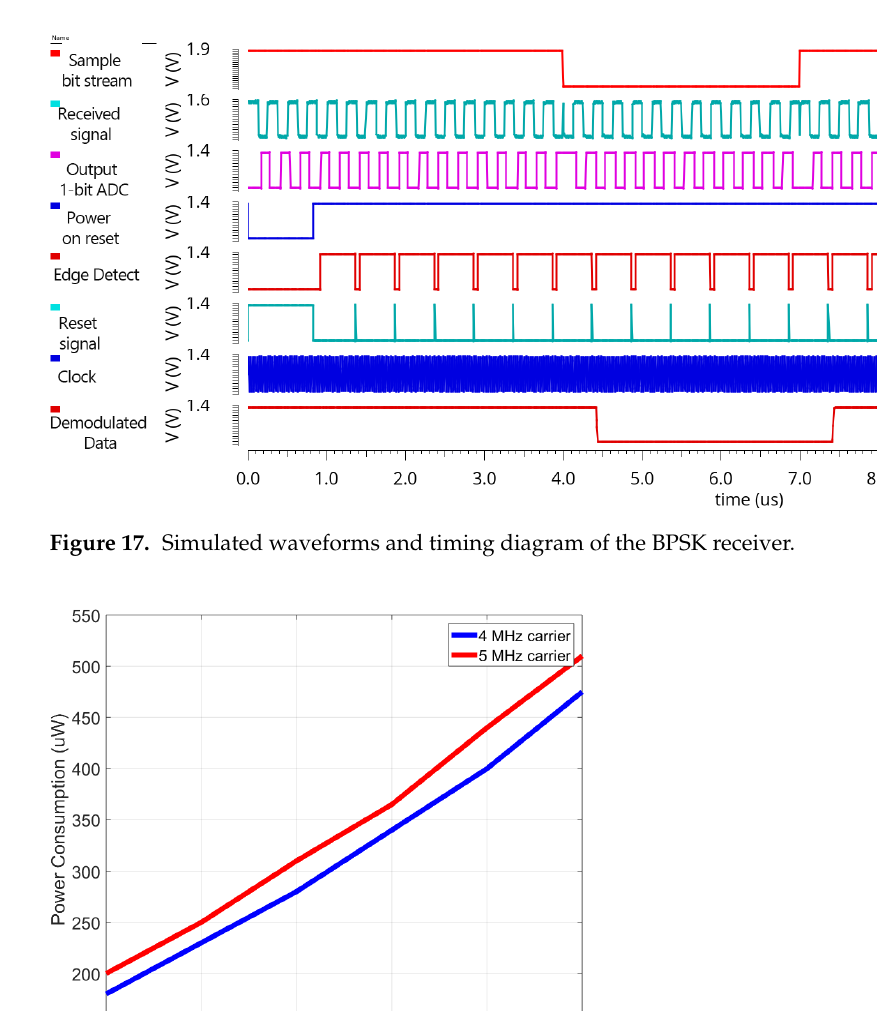
Figure 16. Measured BPSK receiver recovered bits on 1 Mbps on 4 MHz carrier.